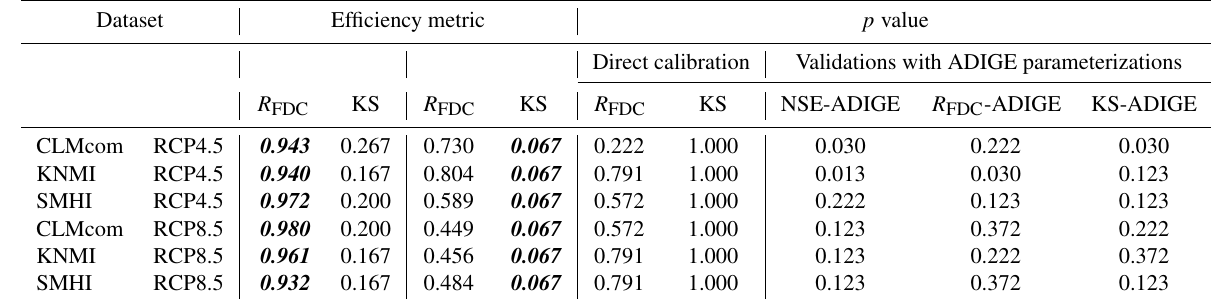
Table 4. The R FDC and KS efficiency metrics for the 1982–2010 period with forcing provided by the CLMcom, KNMI and SMHI climate models under the respective RCP4.5 and RCP8.5 emission scenarios. Bold italic numbers indicate the metric optimized in the calibration. The p values of the Kolmogorov–Smirnov (KS) test are also reported for all of the calibration experiments and for the validations conducted using the NSE-ADIGE, KS-ADIGE and R FDC -ADIGE